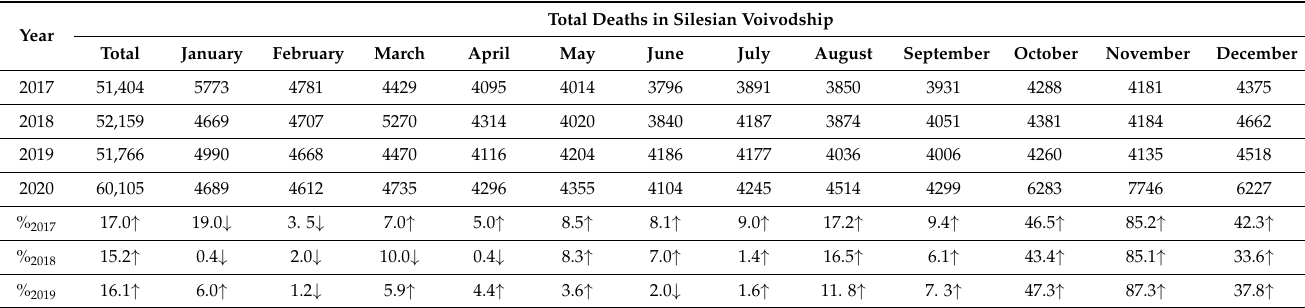
Legend: in the last three lines, the % represents the percentage change (decrease or increase) in the number of deaths in 2020. Compared to previous years. ↑ : increase; ↓ : decrease. Table 3. Yearly and monthly number of total death registered between 2017 and 2020 in Silesian voivodship. Total Deaths in Silesian